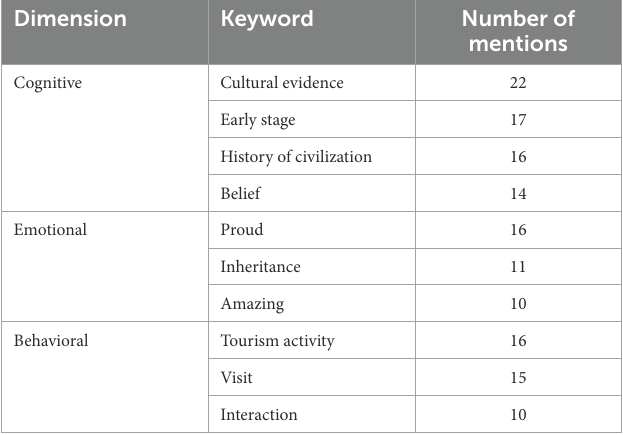
TABLE 2 The qualitative analysis of cultural identity factors.